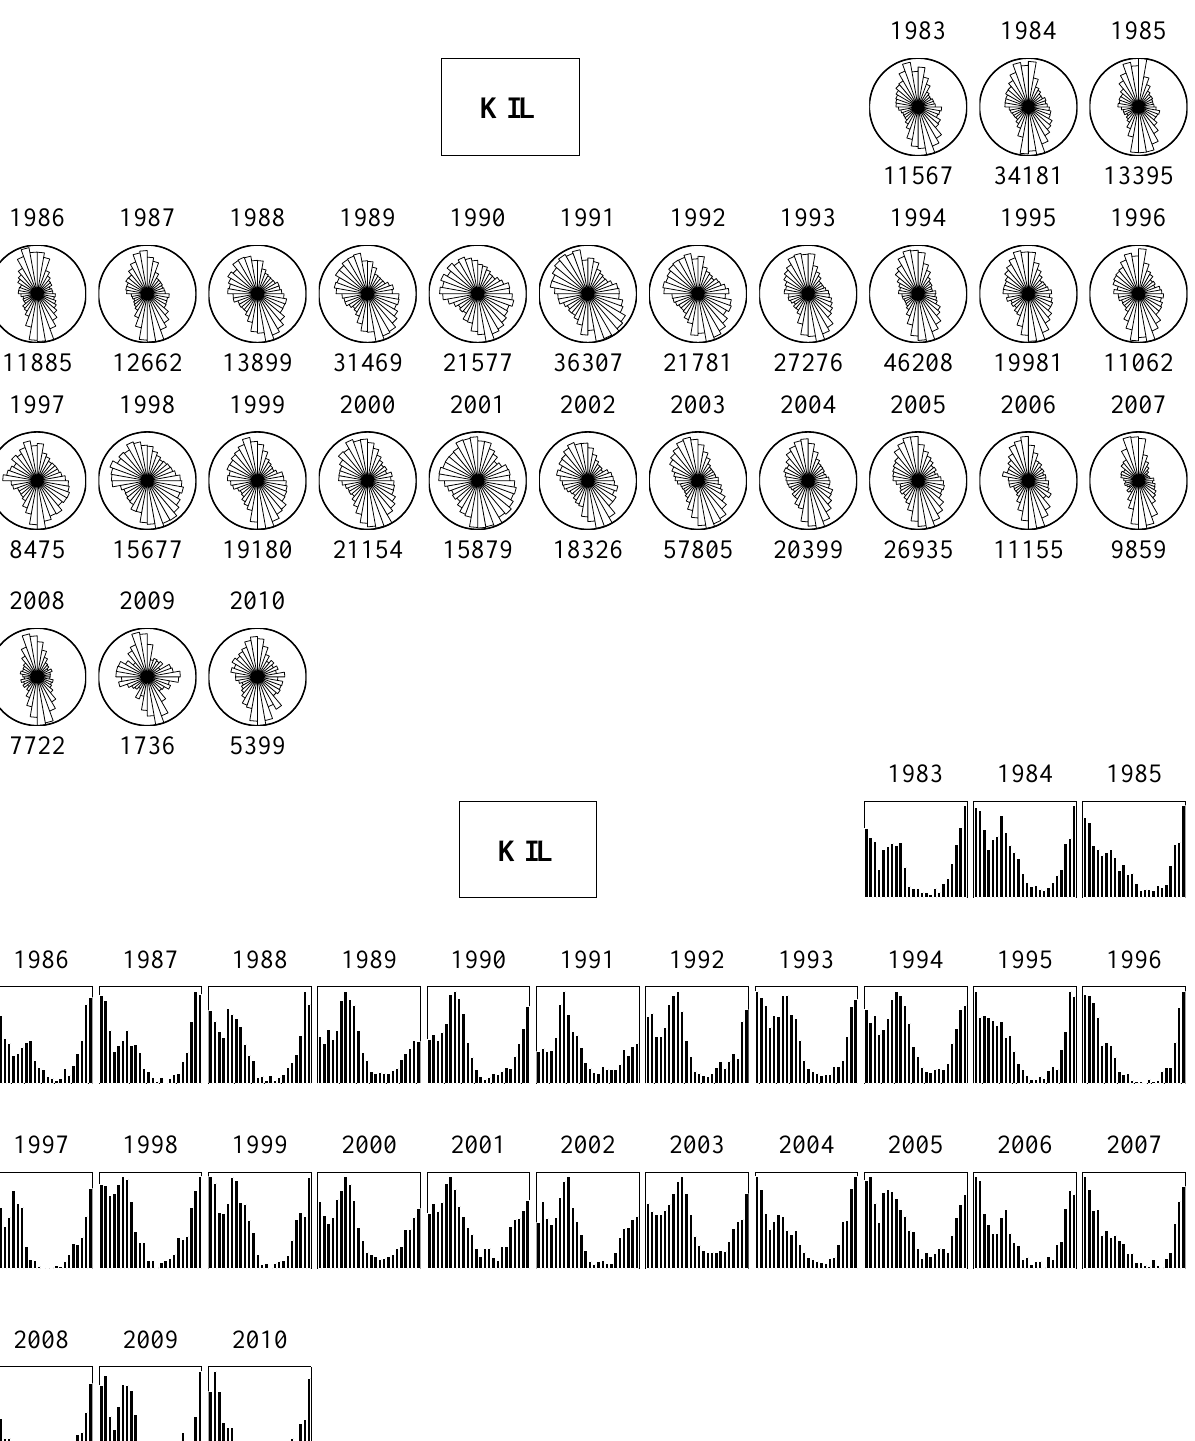
Fig. 5. Upper part: Directional distributions of d H /dt exceeding 1nTs − 1 at KIL. The number of values is given below each yearly plot (due to occasional data gaps, these numbers are not completely comparable). Yearly diagrams are arranged so that the approximate start of each solar cycle is on the left-hand side. Lower part: The normalised diurnal occurrence of large d H /dt values as a function of MLT